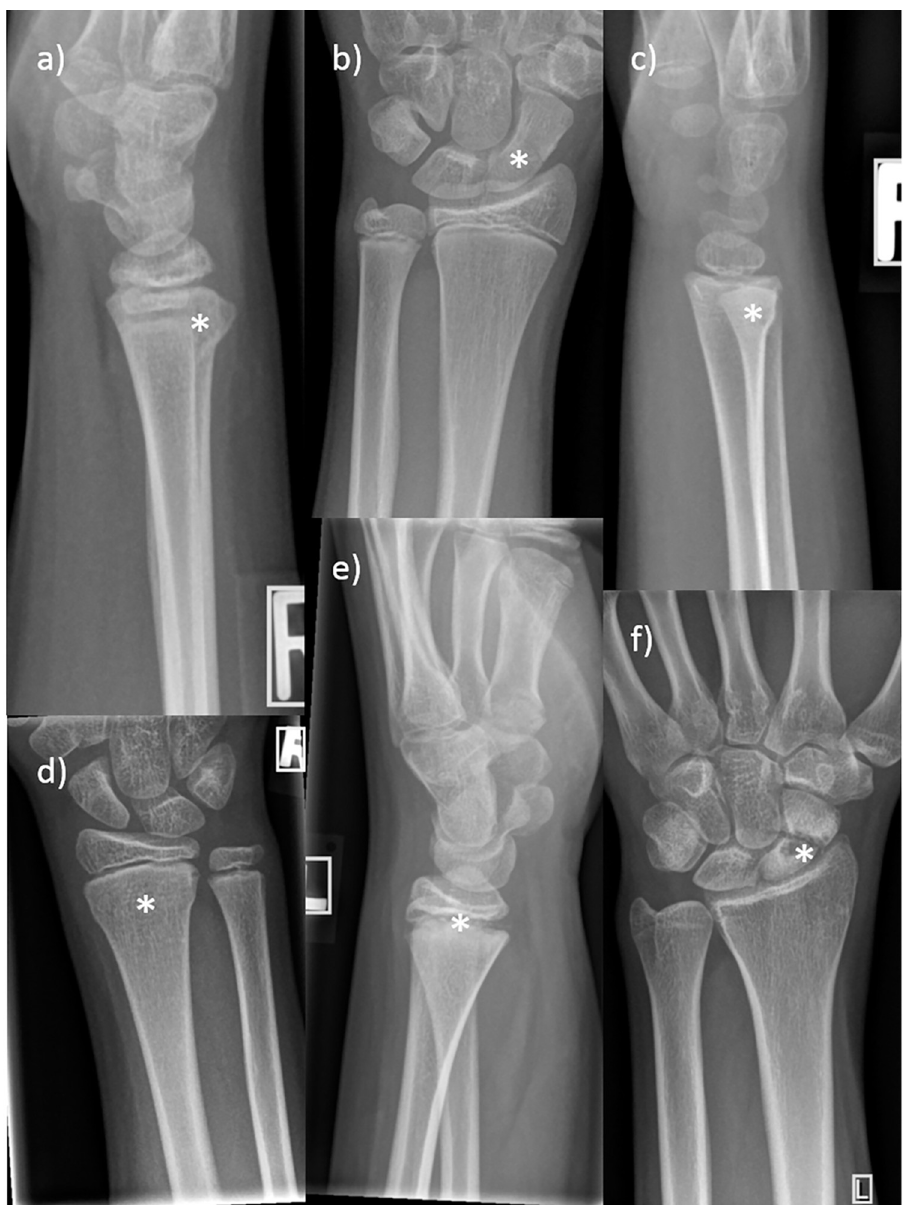
Fig 4. Examples of missed fractures. The stars mark the areas of bone injury. a, c & d) Dorsal compression fractures of the distal radius. b & f) Overlooked scaphoid fractures. e) Missed epiphysiolysis, Salter-Harris type 2.